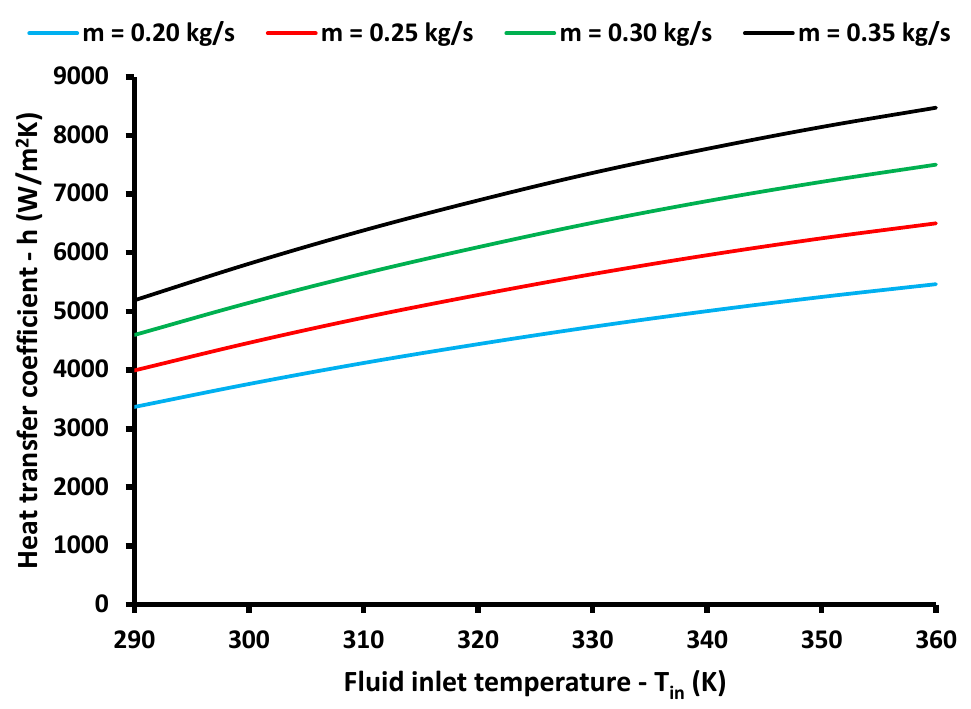
Figure 7. Nusselt number variation for the different operating scenarios in the reference case of the empty tube.